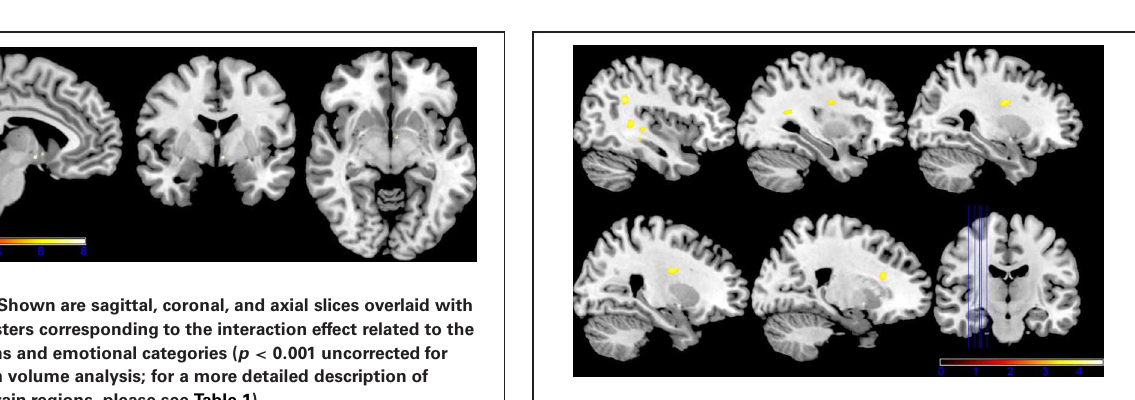
FIGURE 6 | Shown are sagittal and coronal slices overlaid with activity clusters using individual run-specific glucose levels as covariates ( p < 0 . 001 uncorrected for whole-brain volume analysis; for a more detailed description of activated brain regions please see Table